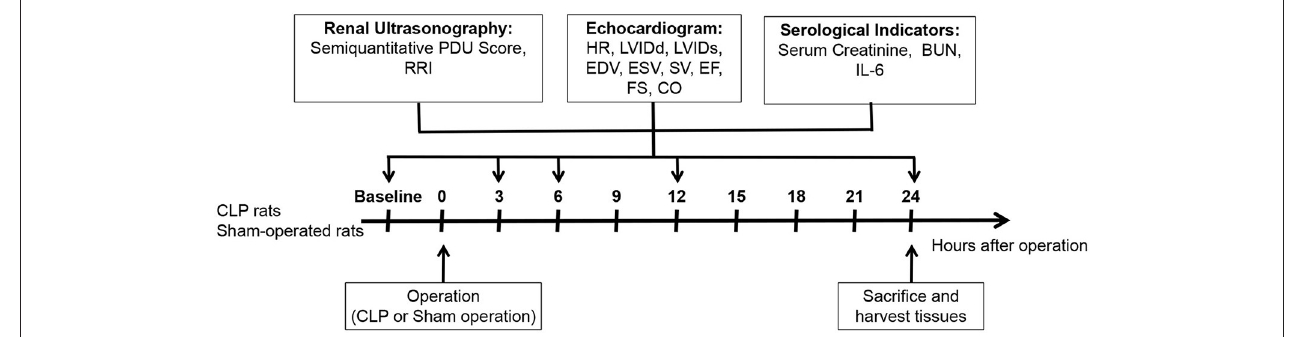
FIGURE 1 | Schema of study design. Thirty-one male Sprague-Dawley rats at the age of 12–14 weeks were randomly divided into CLP group and control group. Two CLP rats were excluded due to the death after CLP, and 23 CLP rats and six sham-operated rats were finally included. Renal ultrasonography and echocardiogram were performed before and at 3, 6, 12, and 24h after the operation, and SCr, BUN, and IL-6 at each time point were detected.